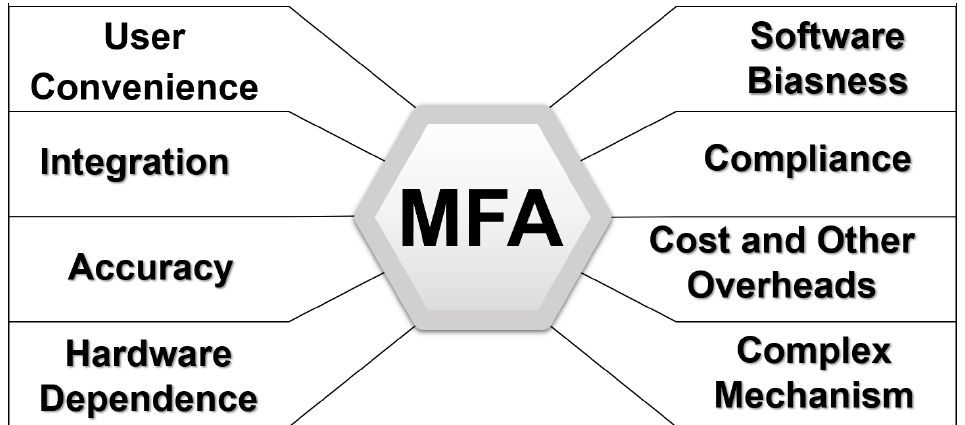
Figure 8. Issues and challenges in MFA implementation